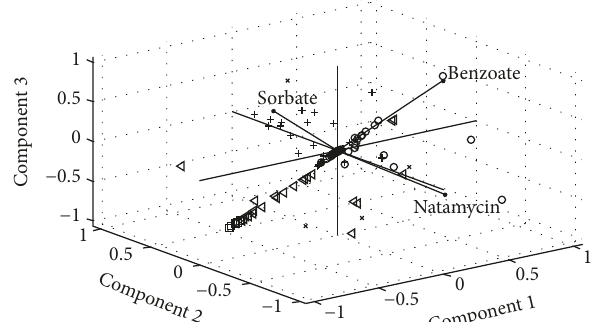
Figure 8: Biplot of first three principal components for the cheese data.